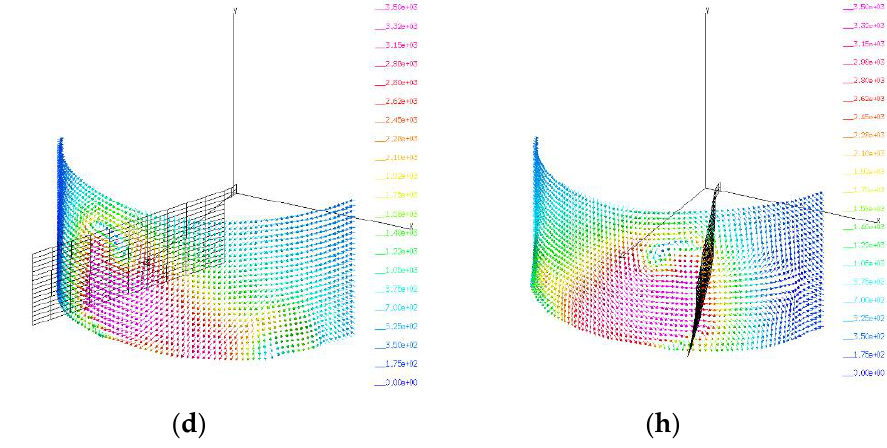
Figure 16. Wing’s flapping motion and the surrounding flow during the upstroke, where the wing flaps from right to left in the left column, and the wing flaps from left to right in the right column: ( a ) The time instant of 8.48 cycle; ( b ) The time instant of 8.60 cycle; ( c ) The time instant of 8.72 cycle; ( d ) The time instant of 8.84 cycle; ( e ) The time instant of 8.96 cycle; ( f ) The time instant of 9.08 cycle; ( g ) The time instant of 9.20 cycle; ( h ) The time instant of 9.32 cycle.